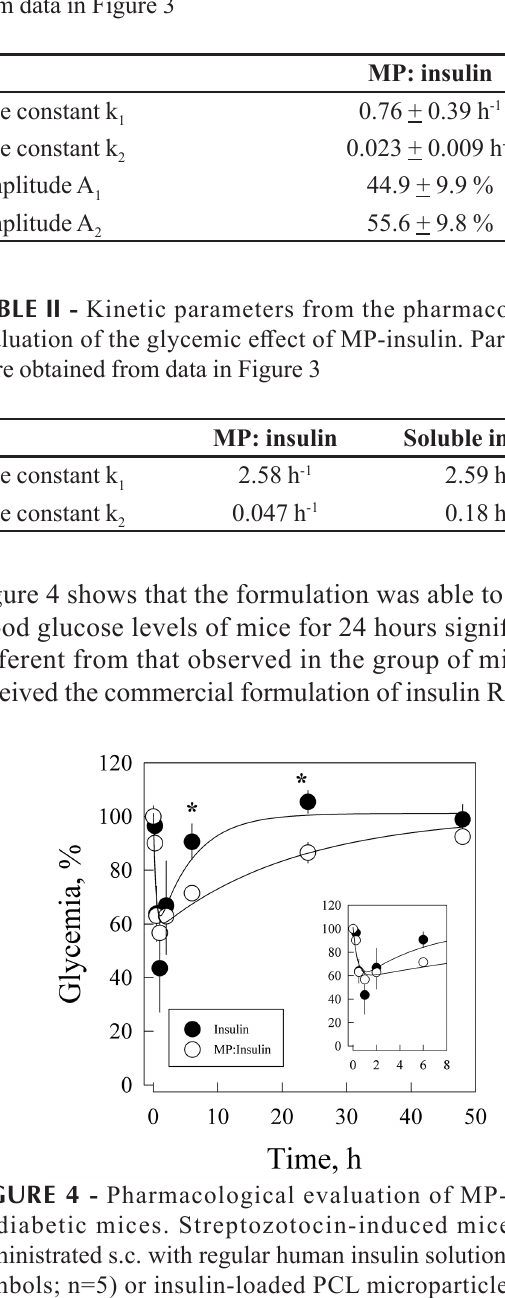
TABLE I - Kinetic parameters from the in vitro release of human insulin from the PCL microparticles. Parameters were obtained from data in Figure 3